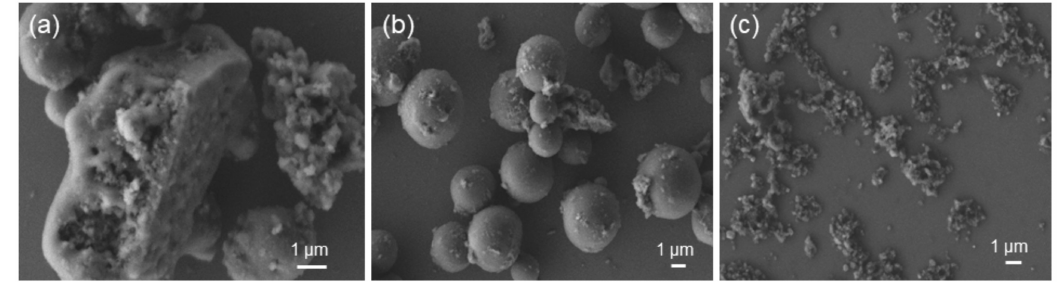
Figure 6. SEM images of ( a ) Zn / Al LDH, ( b ) amino-LDH, ( c ) Mn1@aL.